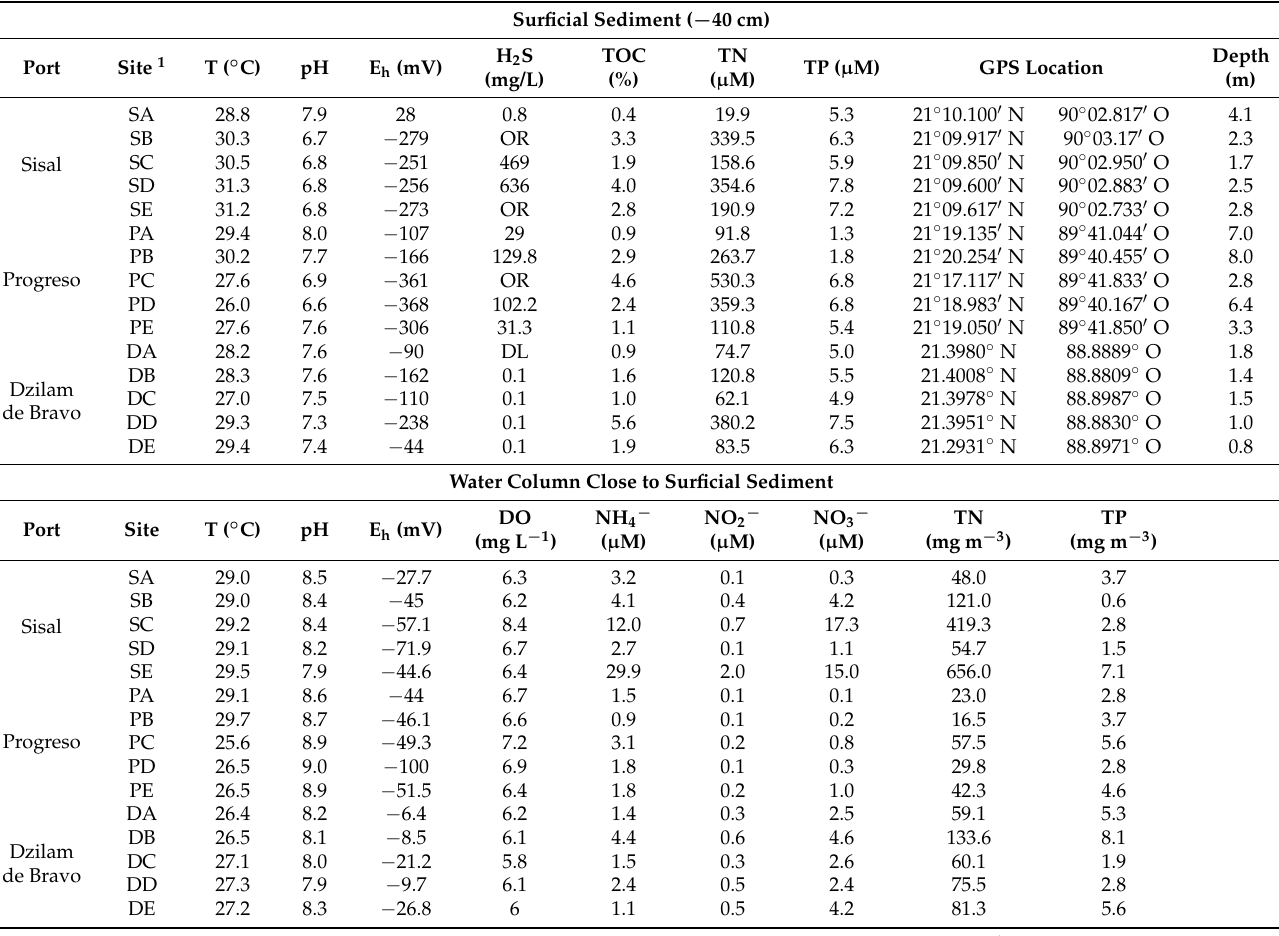
Table 1. Physicochemical characteristics of surficial marine sediments and water column collected in the Sisal, Progreso and Dzilam de Bravo ports in the Yucatan Peninsula, Mexico (GPS Location and depth to reach the